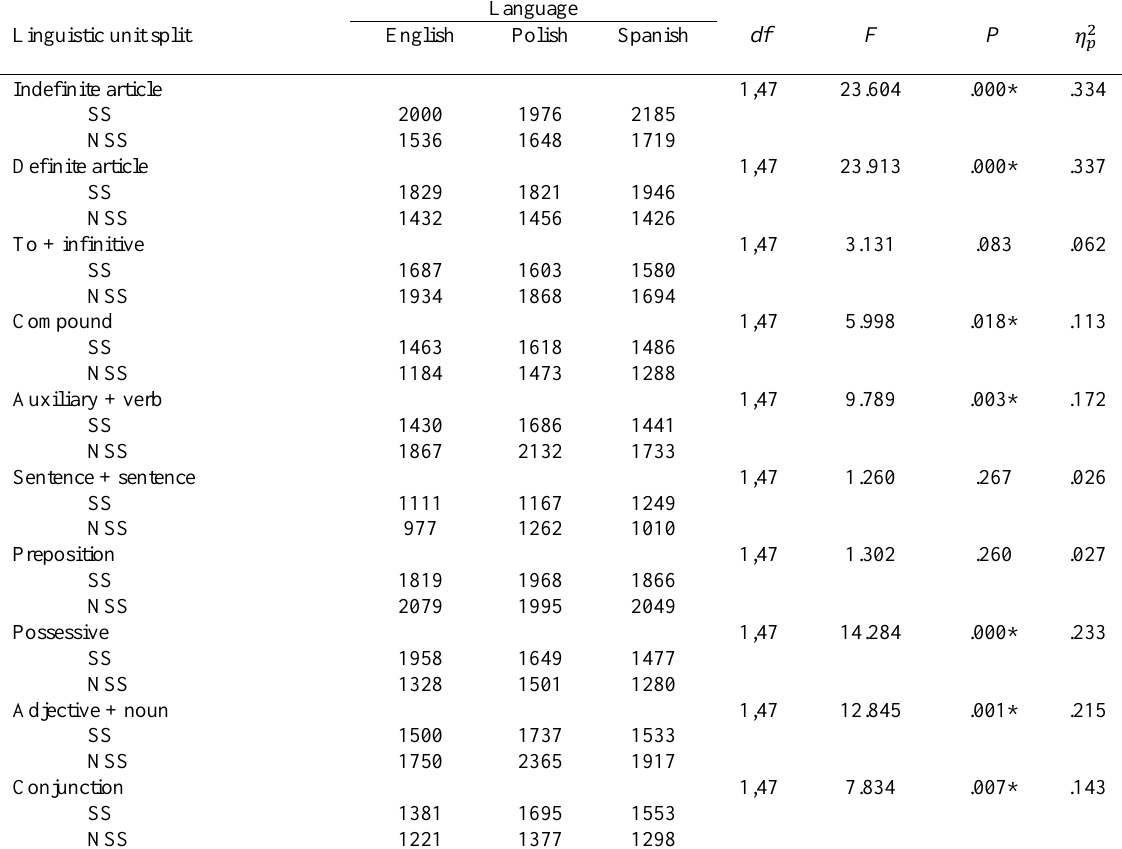
Table 4. Dwell Time on subtitles by linguistic unit and segmentation